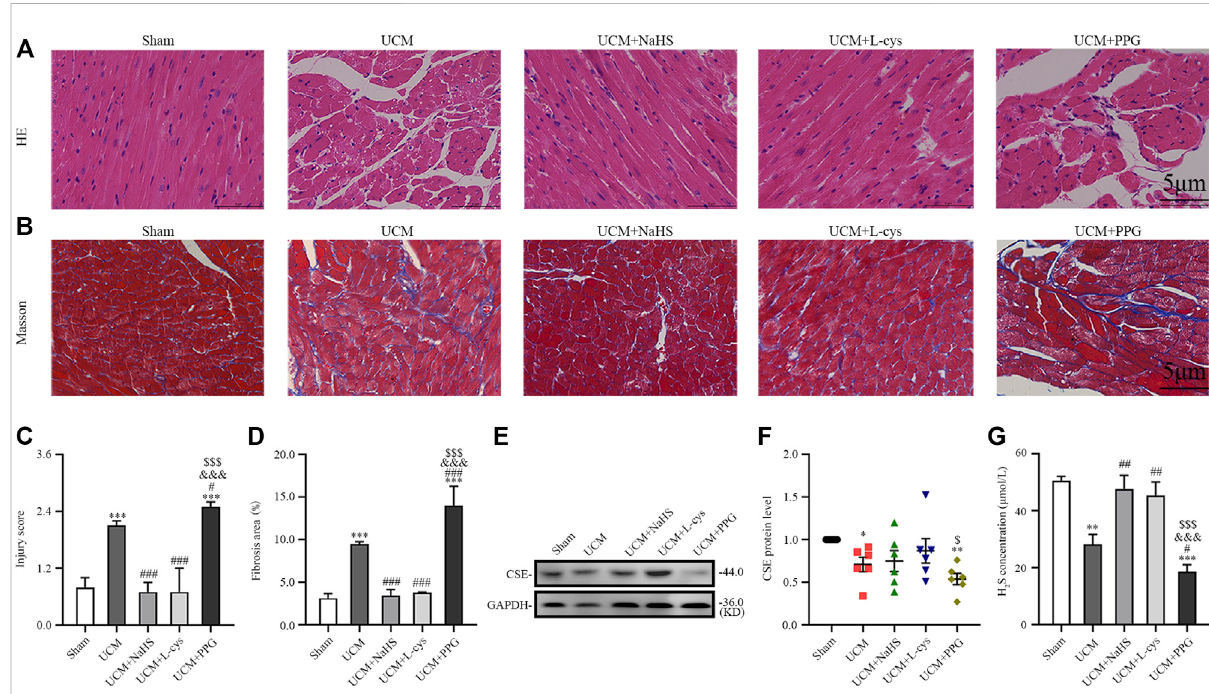
FIGURE 2 H 2 S treatment inhibit myocardial disarray and fi brosis in UCM mice, whereas H 2 S de fi ciency aggravates injuries. (A) Representative images for H&E staining of heart tissues. Scale bar = 5 μ m. (B) Representative images of Masson ’ s trichrome staining of heart tissues. Scale bar = 5 μ m. (C) Statistical testing results of injury level scoring, with n = 3 per group. (D) Statistical testing results of the fi brosis area, with n = 3 per group. (E) Representative Western blot images of CSE expressions in the heart tissue of the fi ve groups of mice. (F) Quanti fi cation of CSE protein expressionsintheinthehearttissueofthe fi vegroupsofmice,with n =6pergroup. (G) Quanti fi cationofH 2 Sconcentrationinthehearttissueofthe fi ve groups of mice, with n = 6 per group. Data are represented as Mean ± SEM. * p < 0.05, ** p < 0.01, *** p < 0.001 vs. Sham group; # p < 0.05, ## p < 0.01, ### p < 0.001 vs. UCM group; &&& p < 0.001 vs. UCM + NaHS group; $ p < 0.05, $$$ p < 0.001 vs. UCM + L-cys